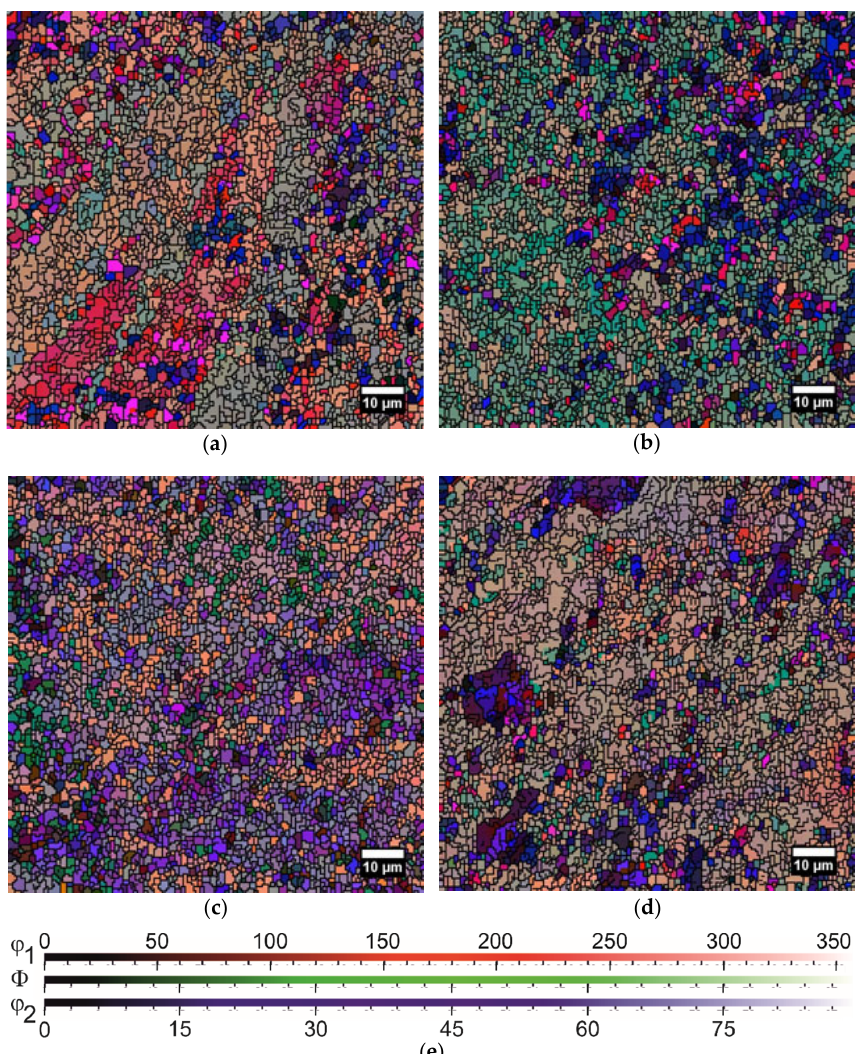
Figure 2. Distribution maps of Euler angles at the center ( a , b ) and at the edge ( b , c ) for cross-sections of AC50 samples after ( a , c ) 8 (sample N2-2) and ( b , d ) 20 (N6) years of service life. The legend